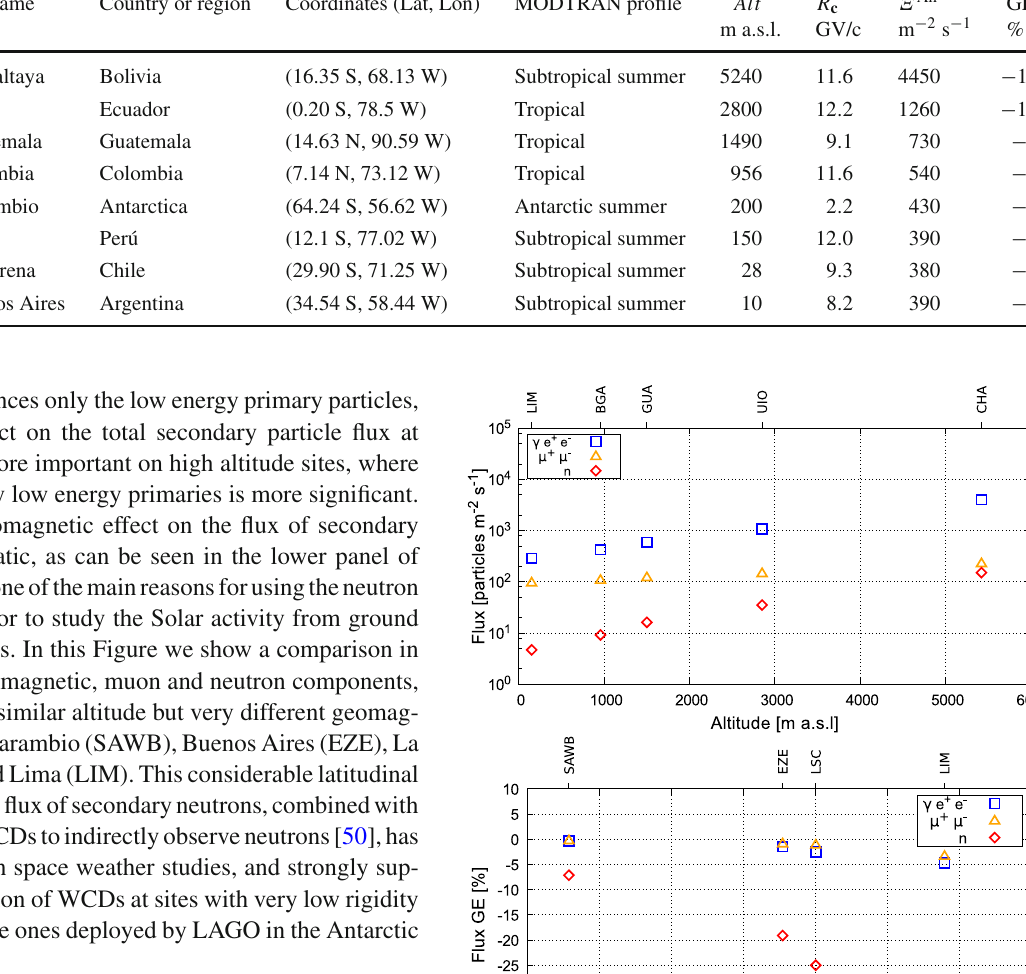
altitude above sea level. The total flux for all secondaries ( Ξ All ) is pre- sented along with the relative geomagnetic effect over the total flux (GE All [%]), estimated as the percent difference with respect to the flux